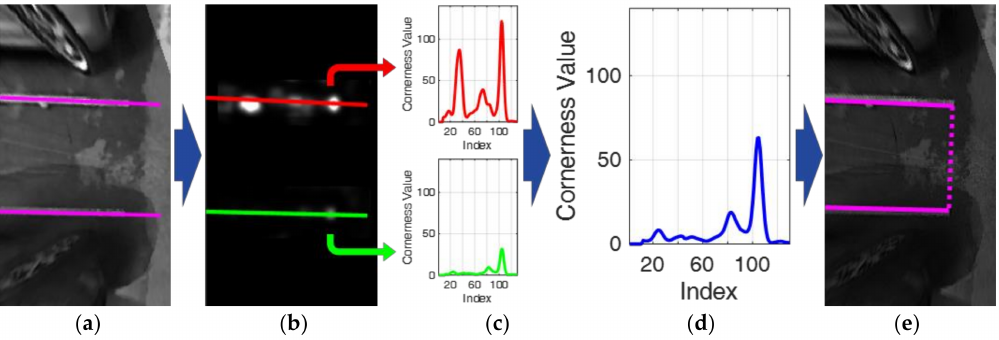
Figure 10. Corner-based entrance detection procedure. ( a ) Separating line pair constituting a parking slot candidate; ( b ) Cornerness values; ( c ) Two cornerness value profiles extracted from two separating lines; ( d ) Combined cornerness value profile; ( e ) Completely recognized parking